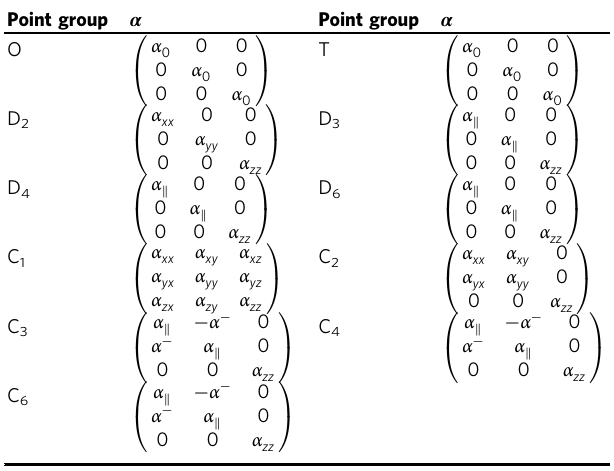
Table 1 of Magnetoelectric susceptibility pseudotensor α for the chiral crystals in the 11 chiral point